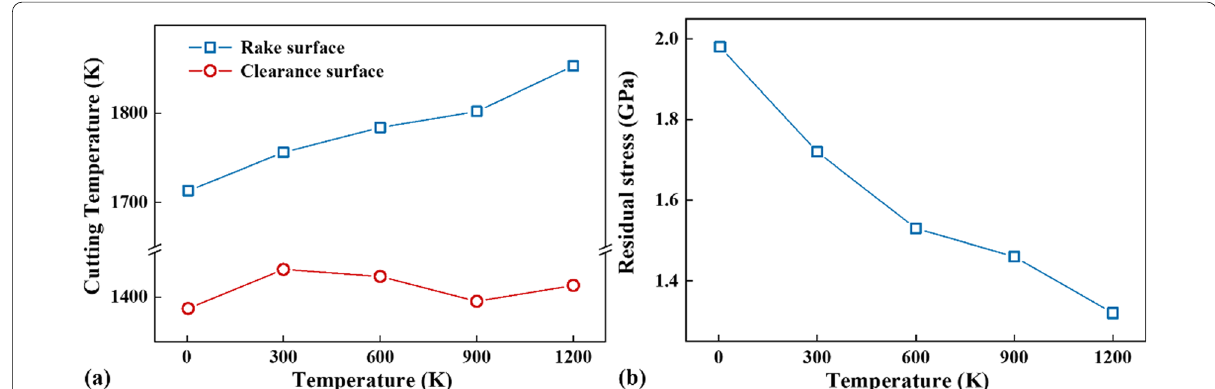
Fig. 11 Maximum tool temperature and residual stress at different temperatures, a tool temperature on rake surface and clearance surface, b residual stress on the machined surface